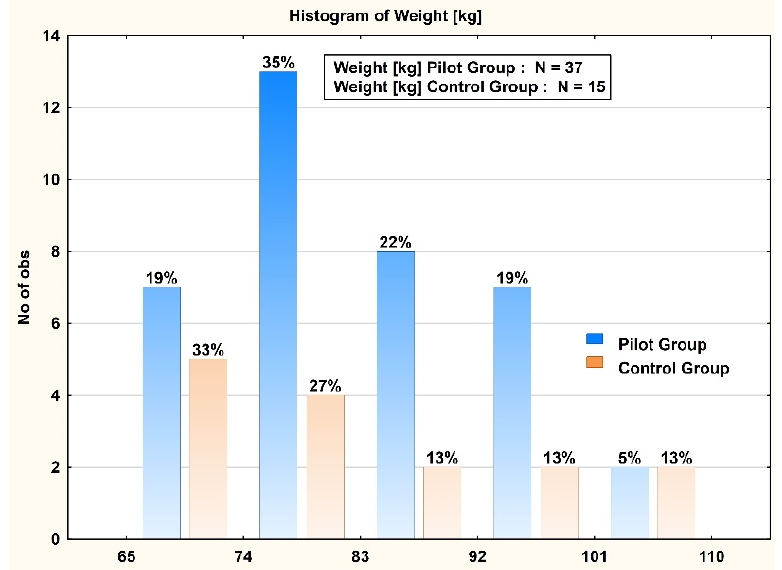
Figure 5. Histogram representation for the weight distribution of the control group (CG) and the pilot group (PG).